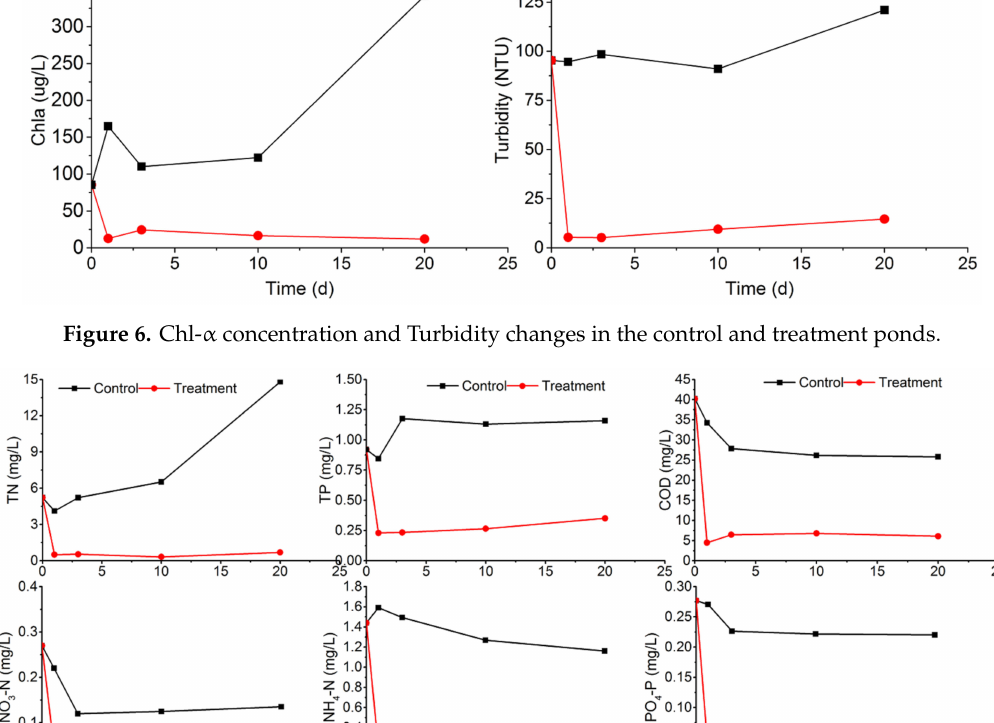
− P in control and 4